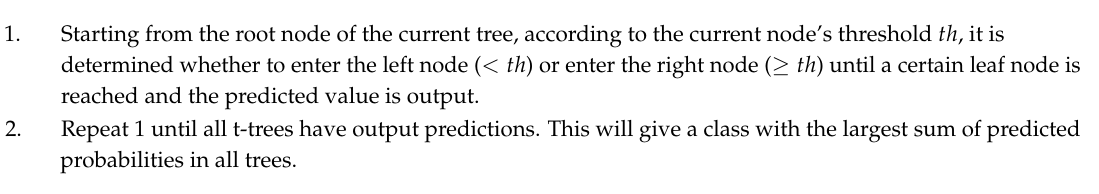
Algorithm 4 Random forest classification